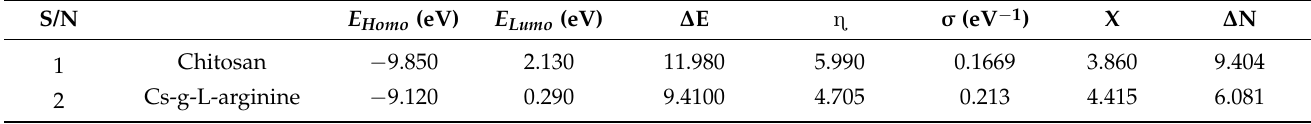
Table 3. Quantum Chemical